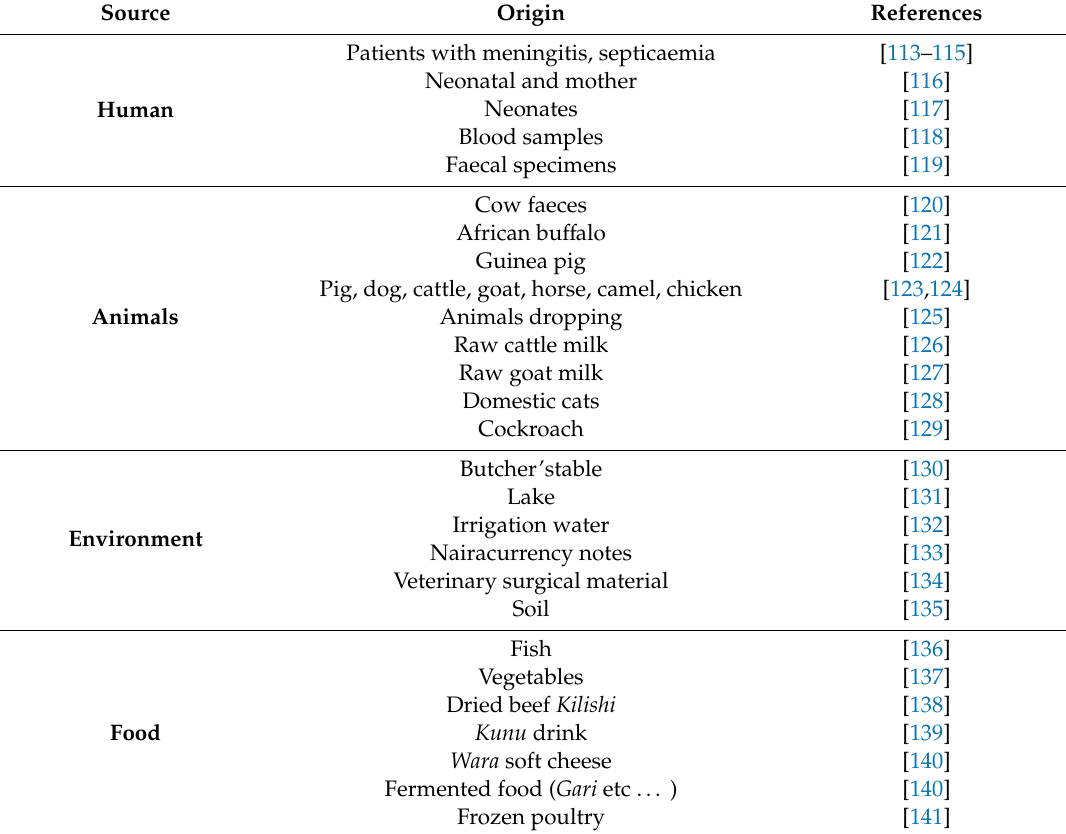
Table 5. Di ff erent sources of Listeria in Nigeria, such as humans, fish, water, animals, soil, and the environment